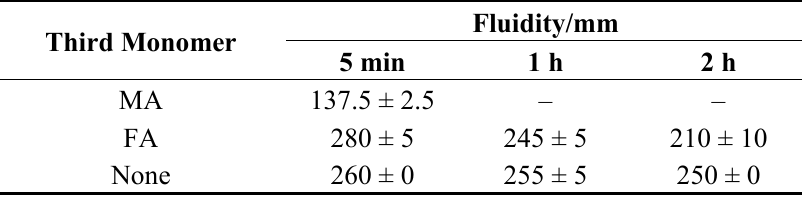
Table 3. Fluidities of cement pastes for PCEs synthesized by adding the third monomer (PCE samples: purified; PCE dosage: 0.2% bwoc). MA, maleic anhydride; FA, fumaric